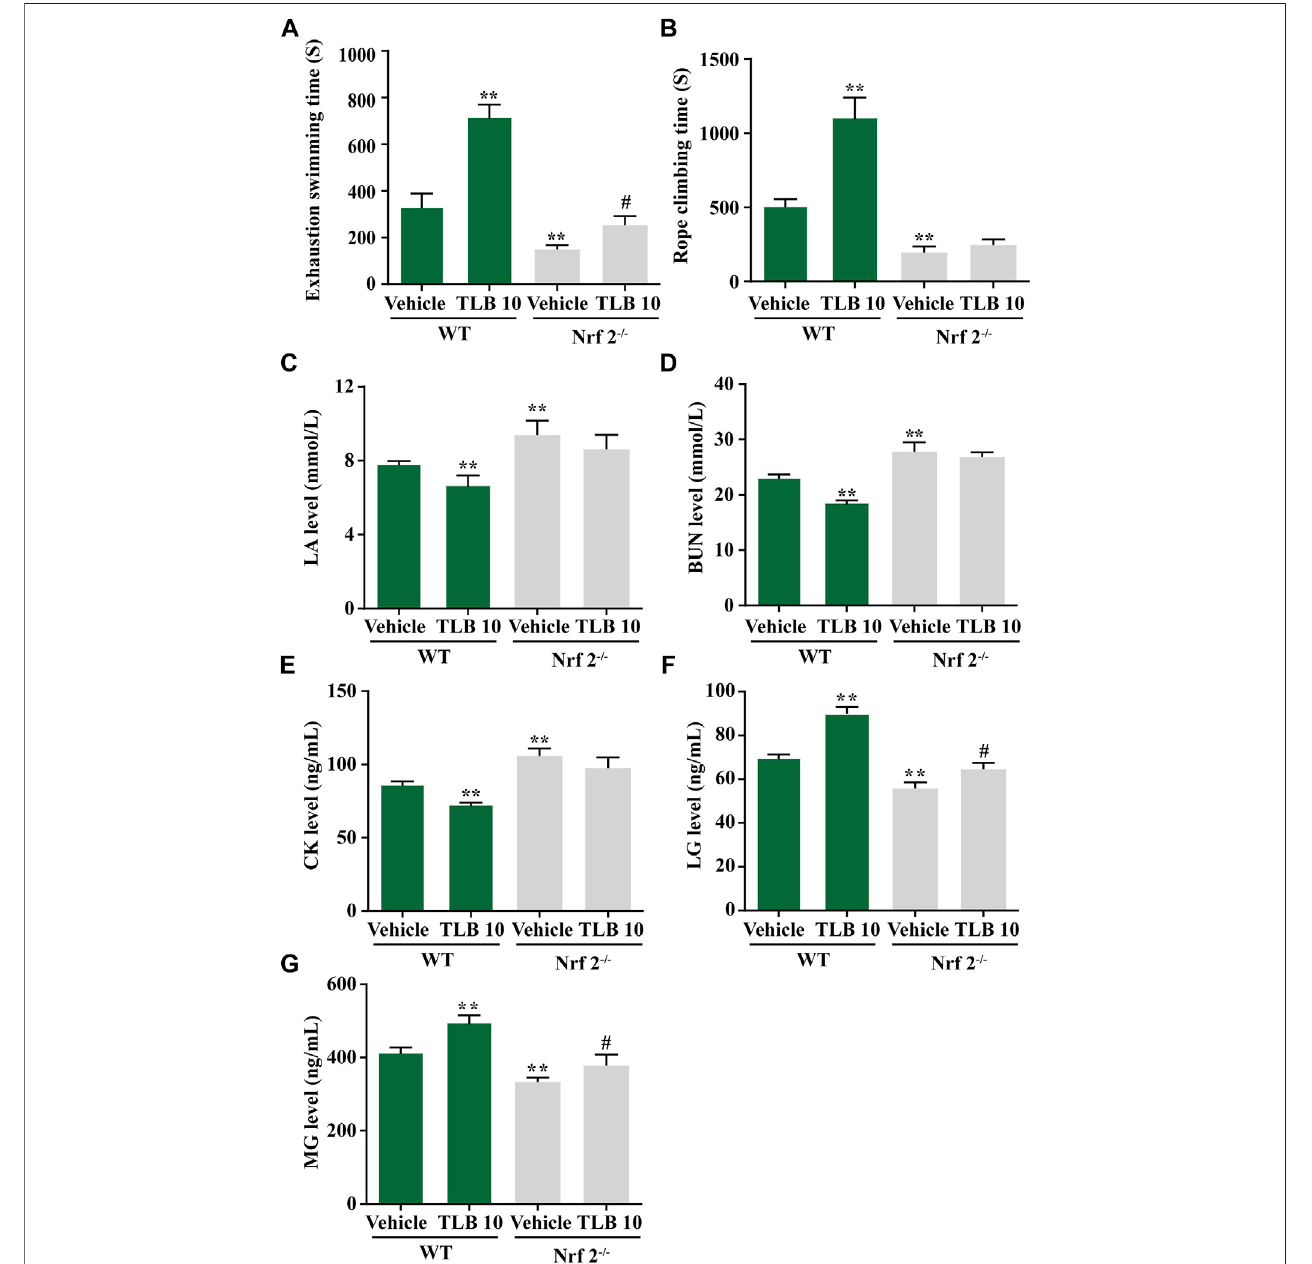
FIGURE5| EffectofTLBonEEIFinNrf2 -/- mice. (A) Exhaustiveswimmingtime, (B) ropingfatiguetime, (C) LAlevel, (D) CKlevel, (E) BUNlevel, (F) LGlevel,and (G) MG level. The data were presented as the mean ± SEM ( n = 10). * p < 0.05 and ** p < 0.01 vs vehicle group. # p < 0.05 vs Nrf2 − / − vehicle group.